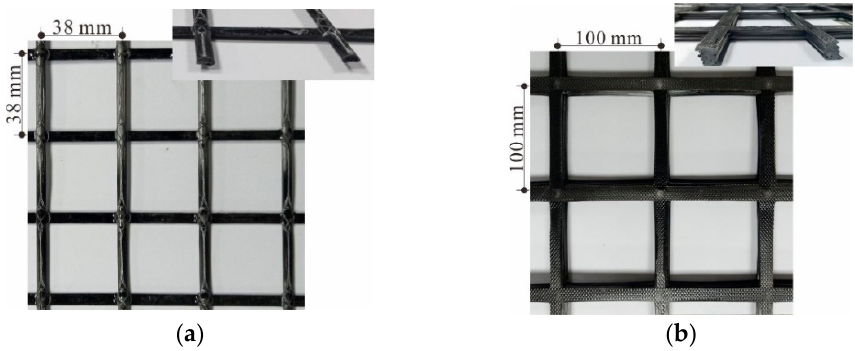
Figure 3. Carbon grids with: ( a ) biaxial warp-knitted; and ( b ) cross-laminate structures.